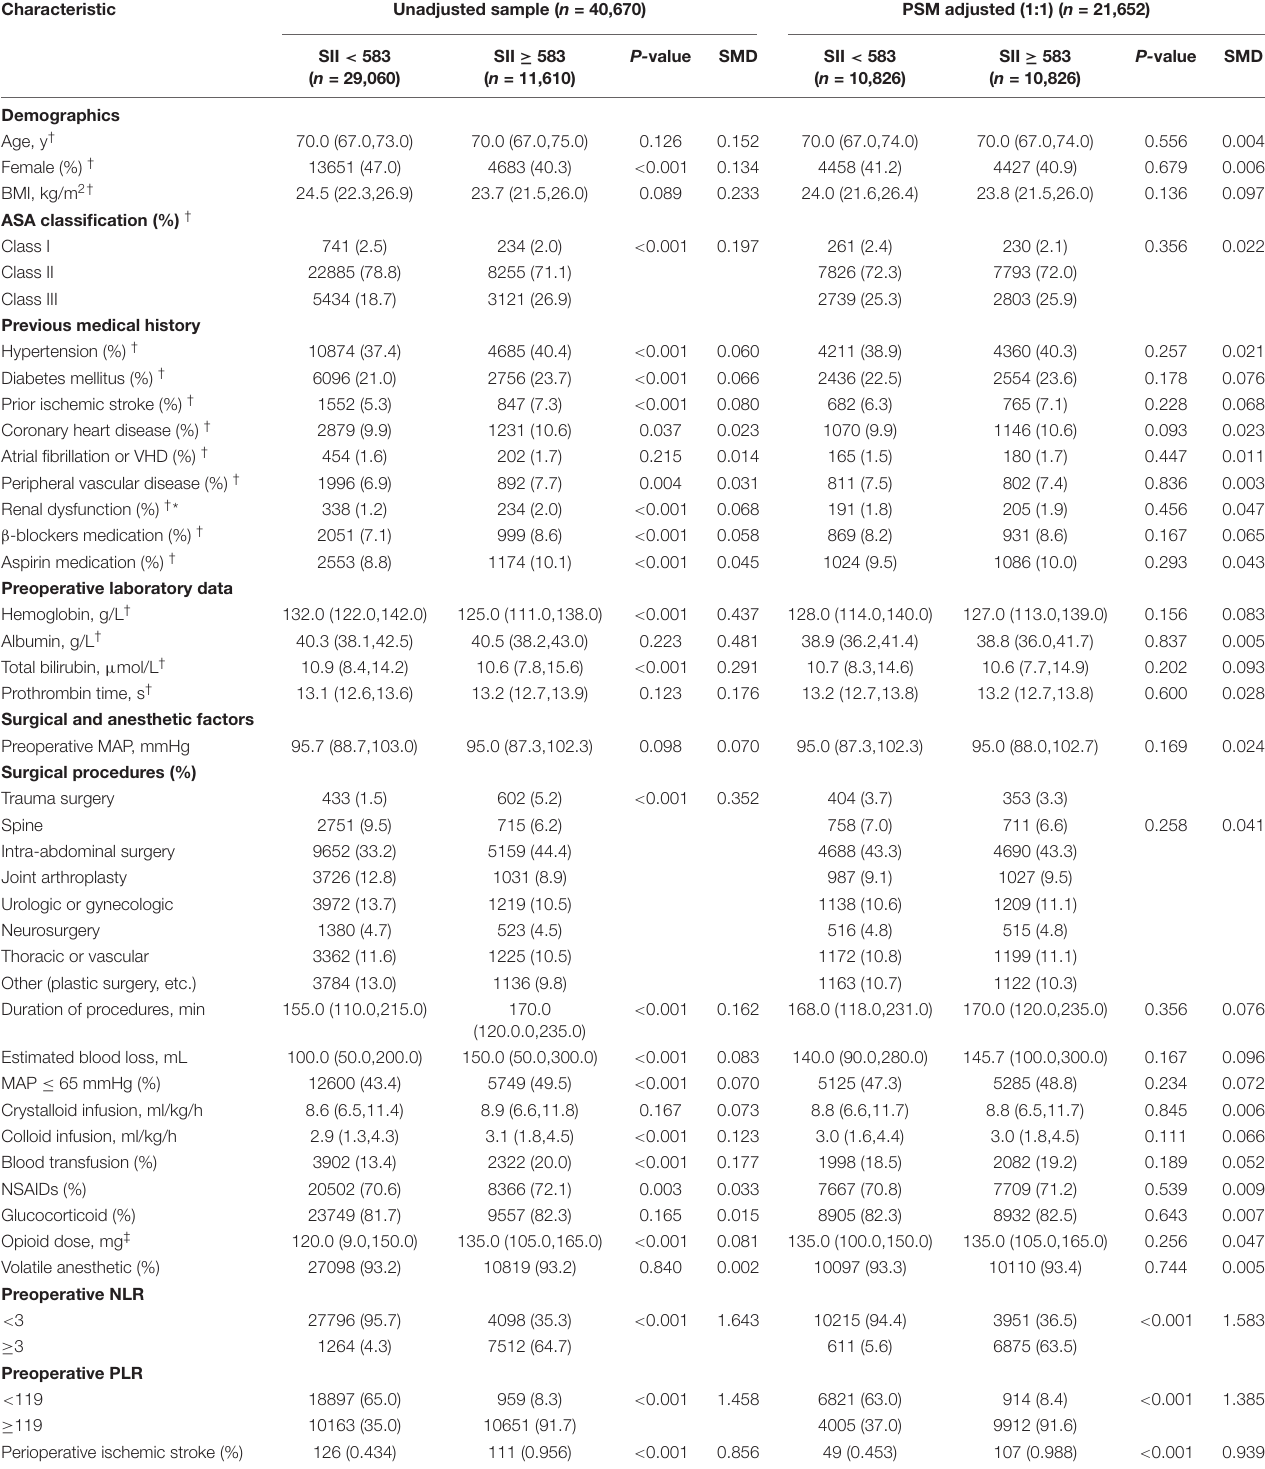
TABLE 1 | Baseline characteristics of unadjusted sample and propensity score-matched sample (patients from 2008–2019). Characteristic Unadjusted sample ( n = 40,670) PSM adjusted (1:1) ( n =